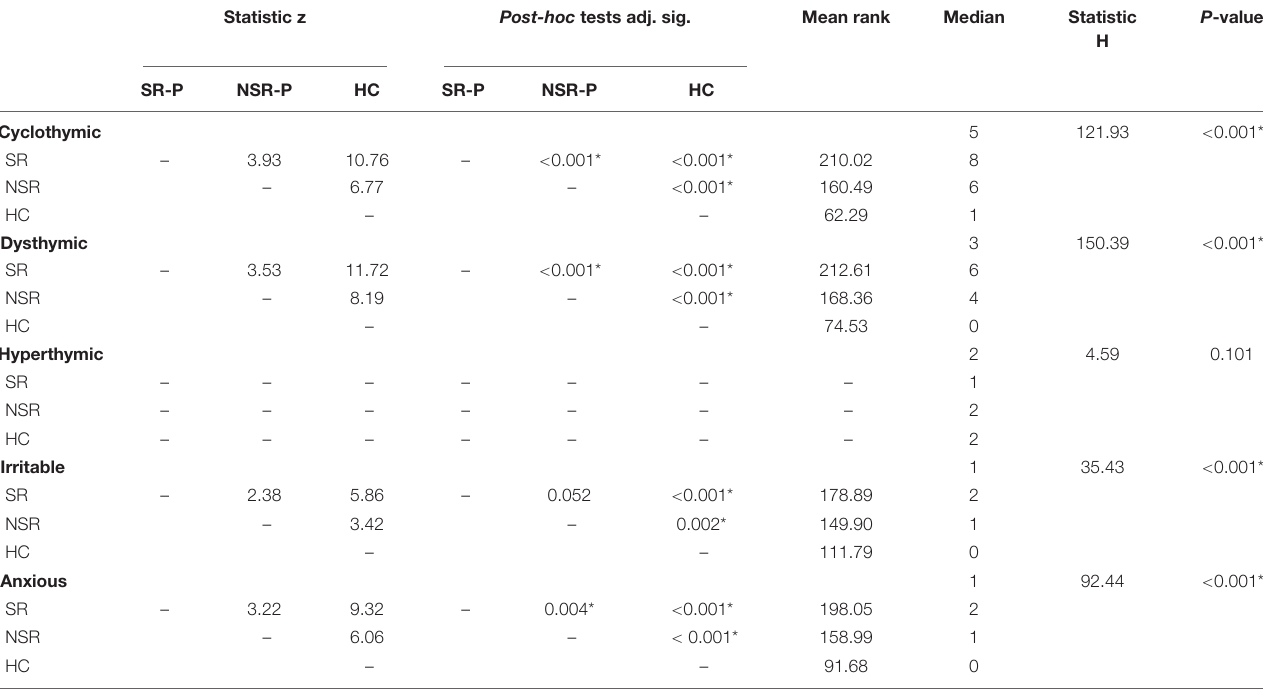
TABLE 4 | Comparisons of TEMPS-A subscales among the SR-P, NSR-P, and HC groups. Statistic z Post-hoc tests adj. sig.